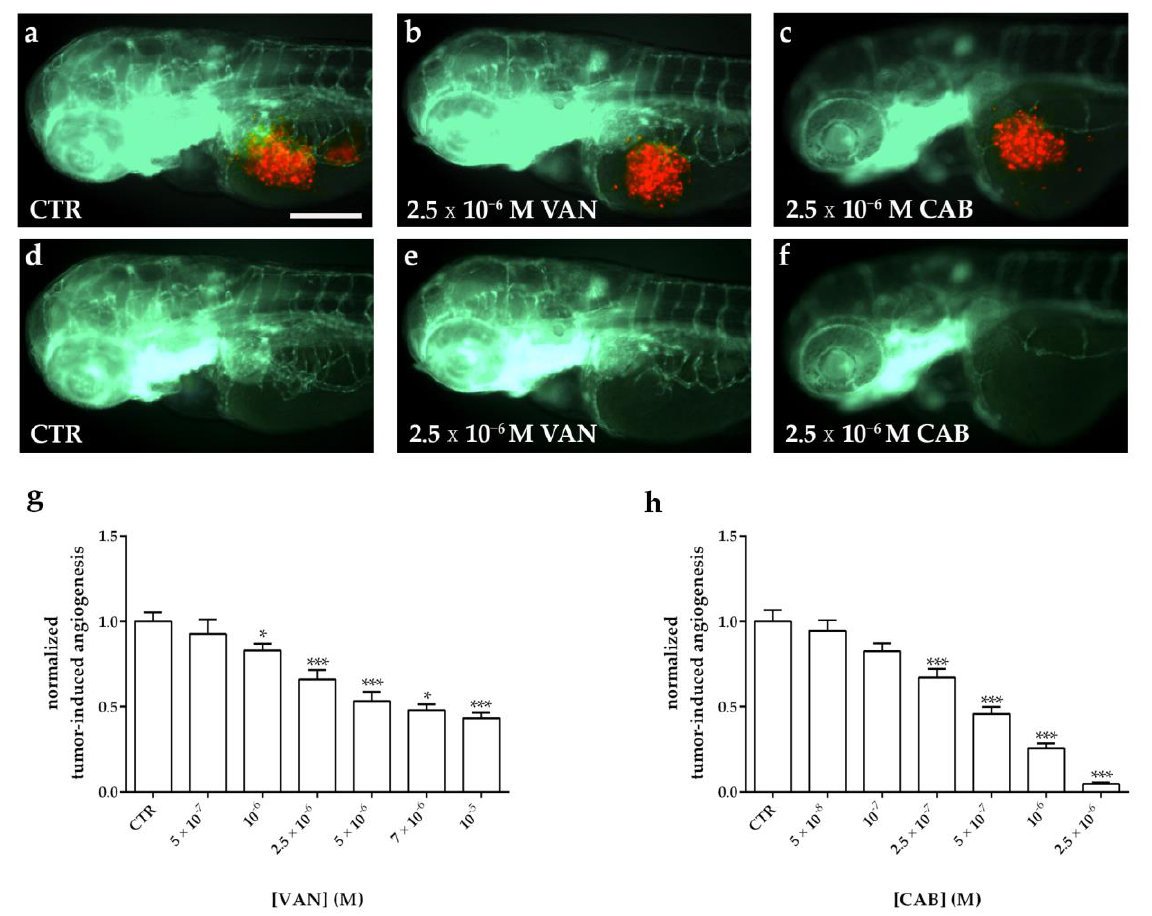
Figure 7. Effect of vandetanib (VAN) and cabozantinib (CAB) treatments on tumor-induced angiogenesis after MZ-CRC-1 cell xenograft in zebrafish embryos. Representative fluorescence images of 72 hpf Tg(fli1a:EGFP) y1 zebrafish embryos implanted at 48 hpf with MZ-CRC-1 cells and subsequently treated for 24 h with dimethyl sulfoxide (DMSO) ( a , d ), VAN ( b , e ) and CAB ( c , f ). The red channel, corresponding to MZ-CRC-1 cells, was omitted in panels d, e, and f to highlight the tumor-induced microvascular network. Grafted larvae showed vessels in green that sprout from the sub-intestinal vein (SIV) toward the xenograft. Quantification of tumor-induced angiogenesis in MZ-CRC-1-injected Tg(fli1a:EGFP) y1 embryos after 24 h of VAN ( g ) and CAB ( h ) treatments at different concentrations. Control (CTR) values have been set to 1.0. Graphed values represent the mean ± S.E.M. * p < 0.05 versus the CTR; *** p < 0.001 versus the CTR. Embryos are shown anterior to the left. Scale bar: 100 µm.